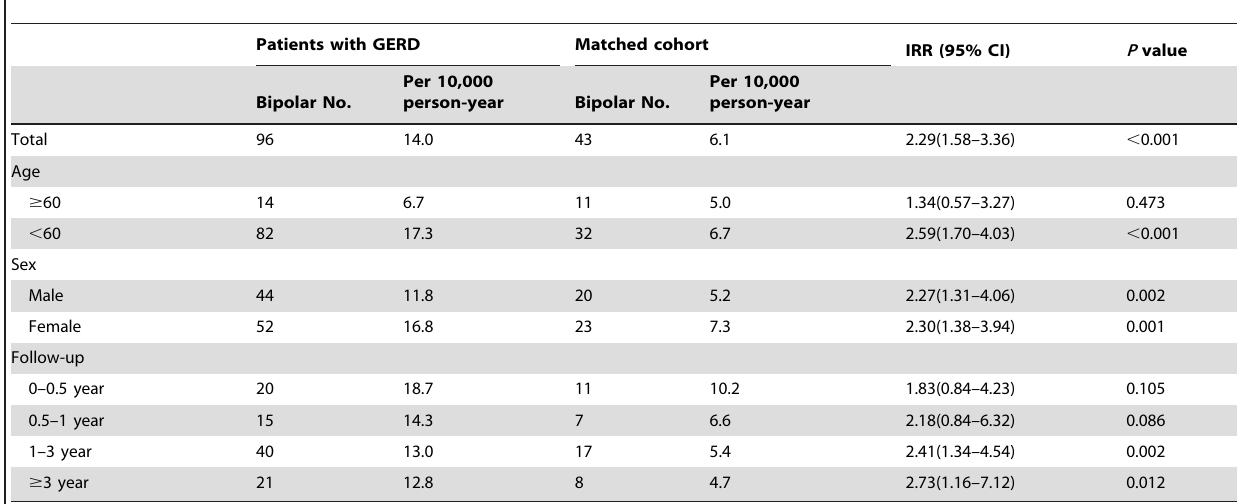
Table 2. Incidence of bipolar disorder in patients with gastroesophageal reflux disease (GERD) and matched cohort.